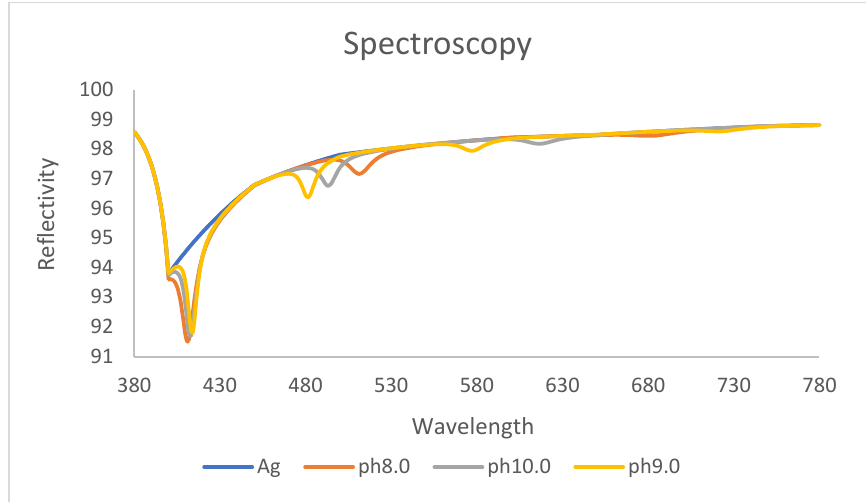
Figure 8. Spectral response spectra of ZnO films prepared at different pH values and only Ag nanoarrays.